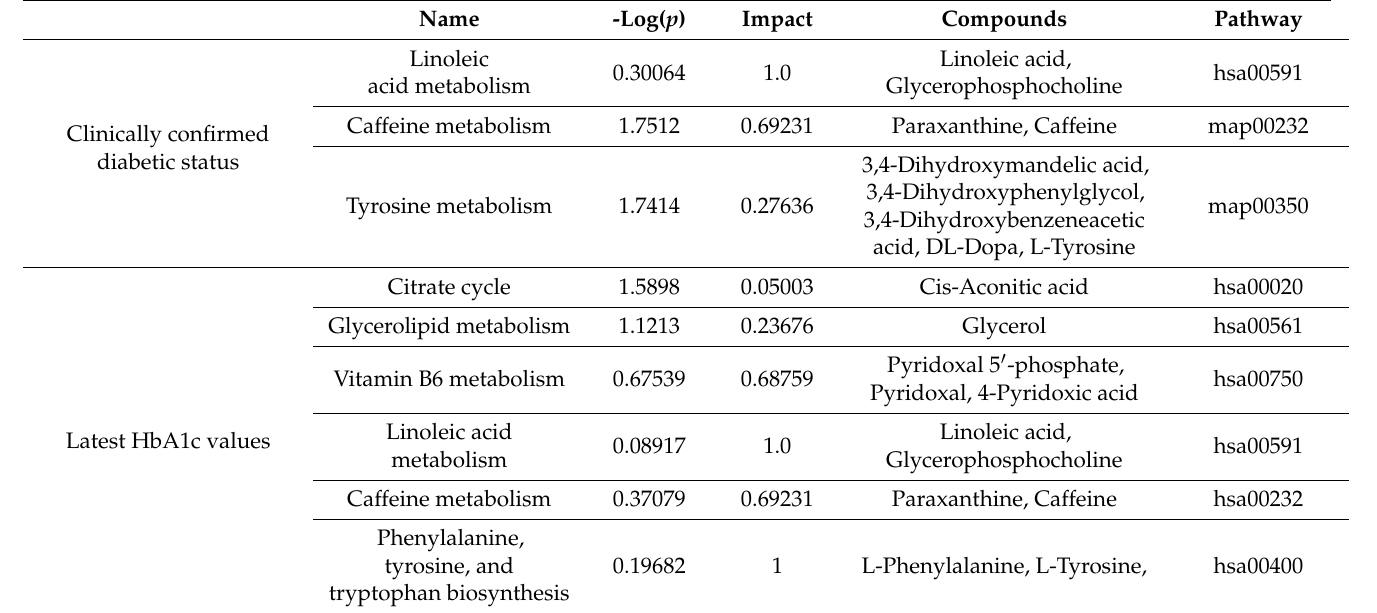
Table 1. Analysis of the top metabolic pathways based on clinically confirmed diabetic status and latest HbA1c